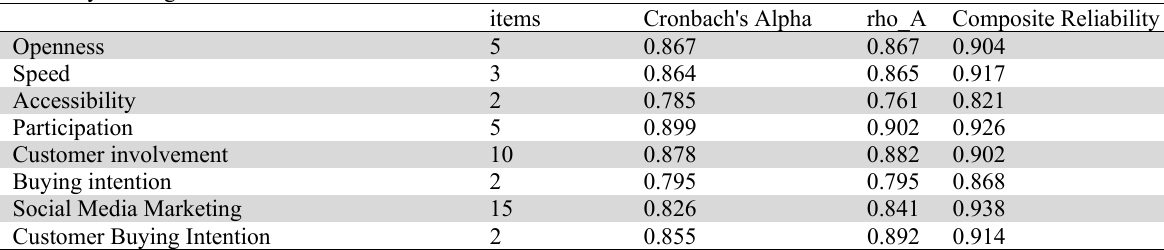
Reliability Testing